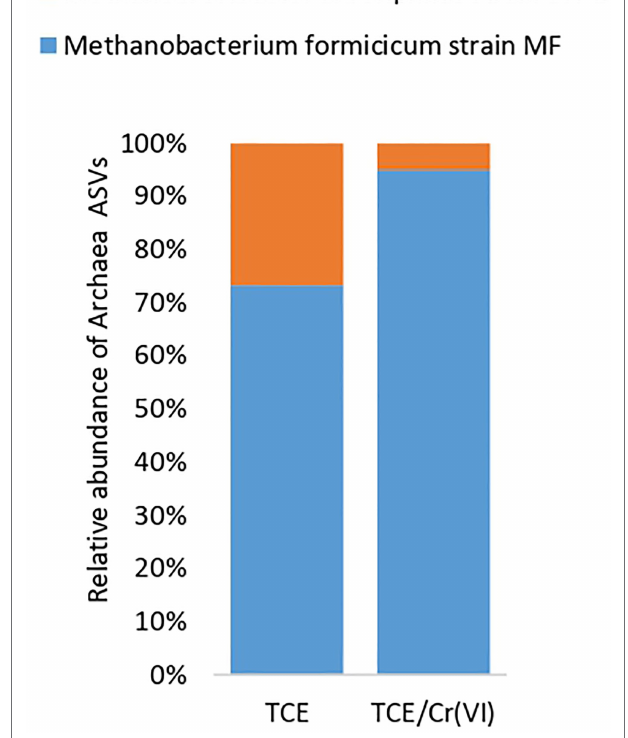
FIGURE 5 | Archaea composition of the cathodic biofilm in the reactor operating with TCE and